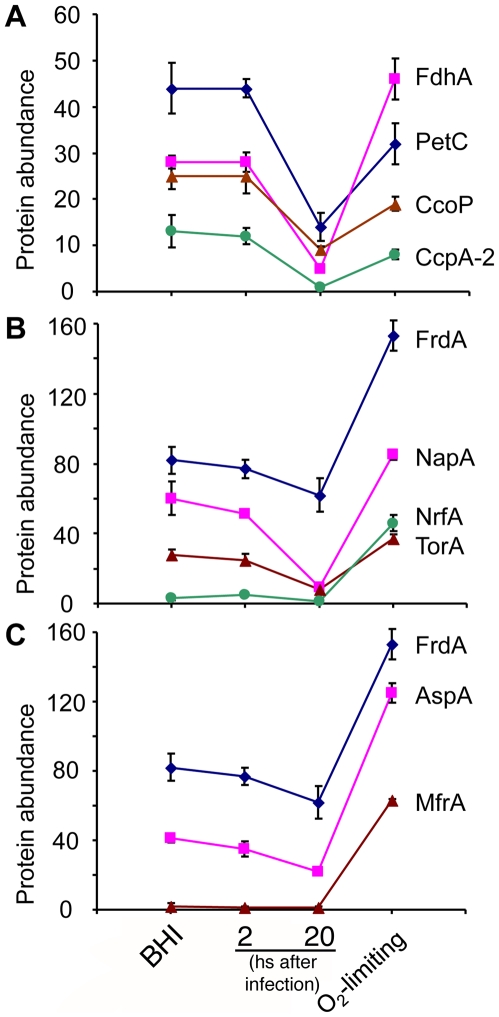
Protein abundance of respiration/electron transport chain components of C. jejuni in four distinct environments.Protein abundance (expressed as spectral counts) in C. jejuni samples obtained after growth in BHI, after 2 and 20 hs after infection, and after exposure to oxygen limiting conditions subsequently to their recovery 20 hs after infection (indicated as O2-limiting). A Protein abundance of representative enzymes involved in aerobic respirations. B Protein abundance of representative enzymes involved in anaerobic respirations. C Protein abundance of enzymes relevant to fumarate respiration. Values represent the mean ± standard error of the mean of three determinations.